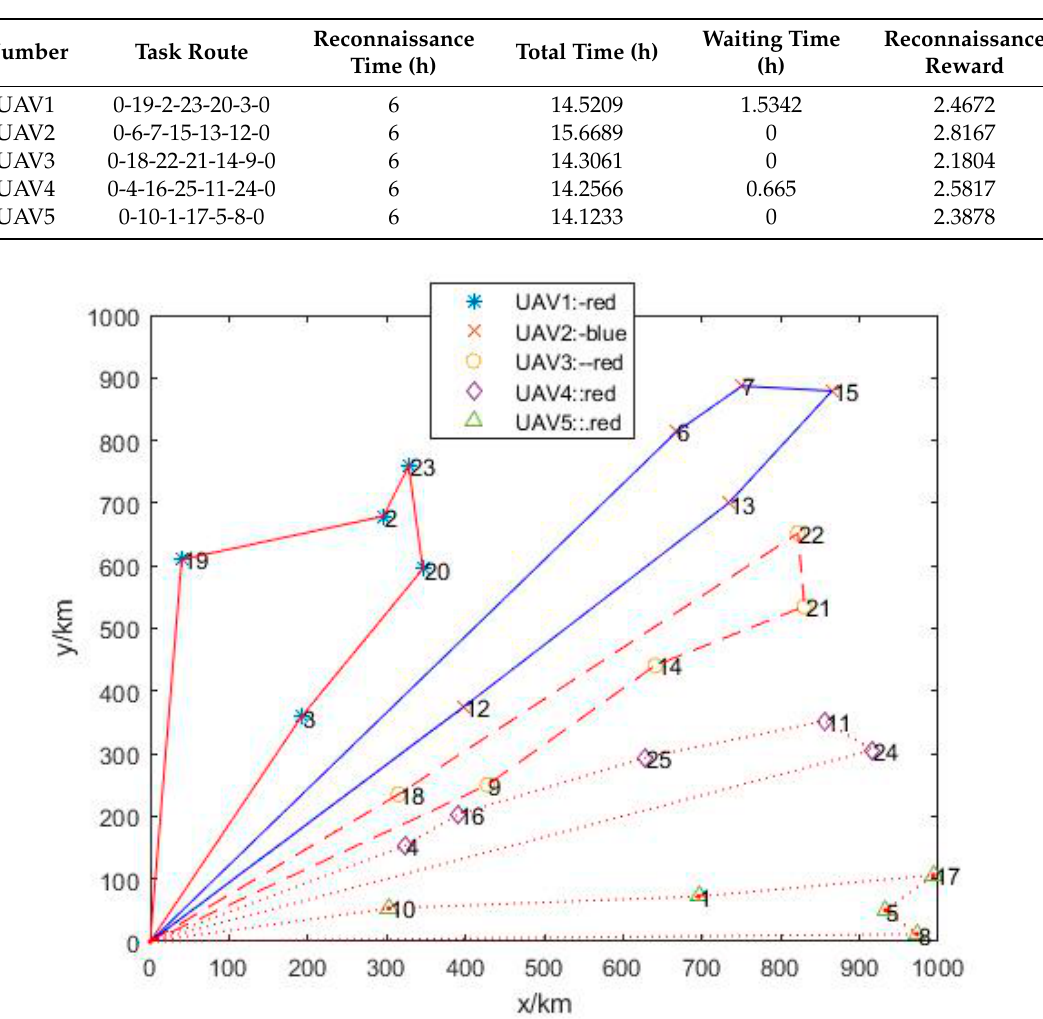
Table 1. Assignment status of each unmanned aerial vehicle (UAV).